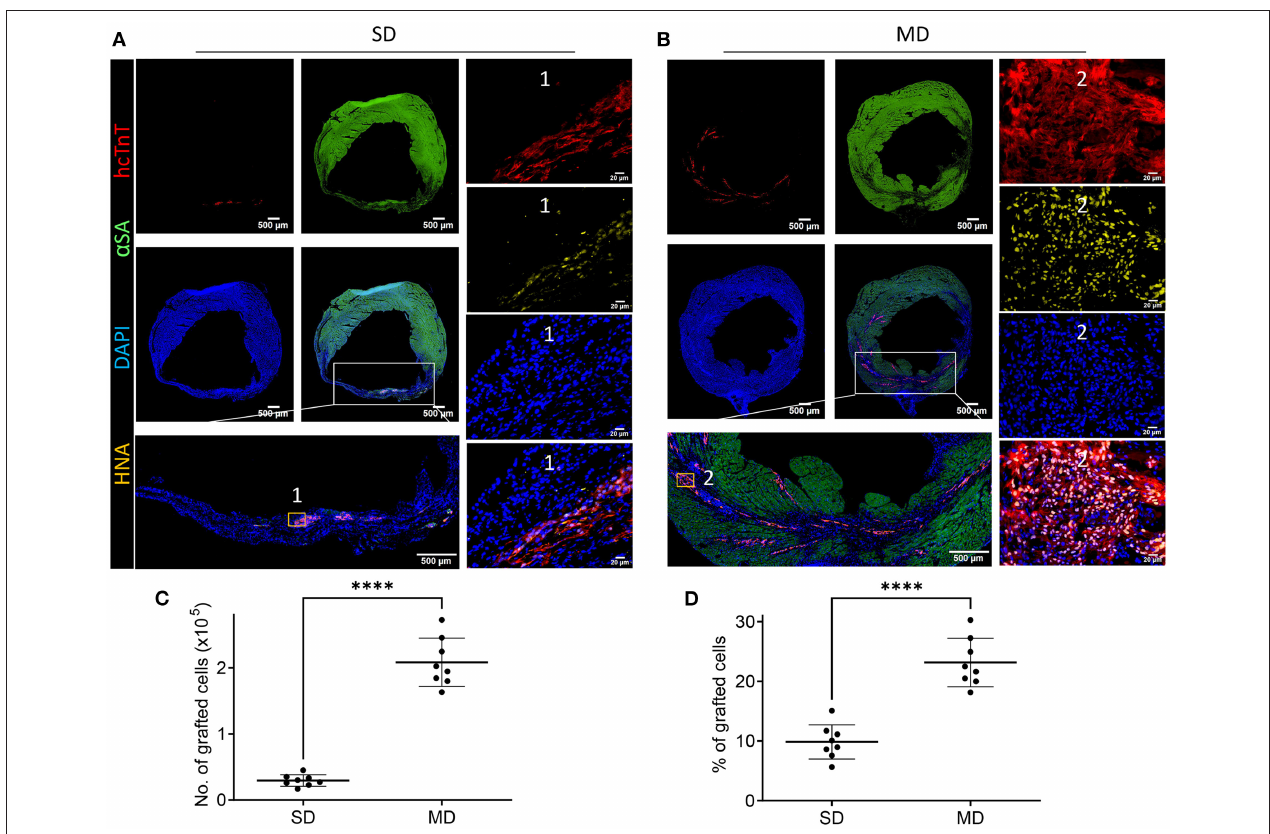
FIGURE 3 | Detection of hiPSC-CMs. Four weeks after MI induction, serial sections of the hearts of mice injected with hiPSC-CM were stained for human cardiac troponin T (hcTnT) and human nuclear antigen (HNA), α -sarcomeric actin ( α SA) and DAPI (A,B) . Transplanted cells were defined as those that expressed hcTnT and HNA and were quantified as the number (C) and percentage (D) of grafted cells. Each heart evaluates 20 parts, and each part randomly selects 5 visual fields for evaluation. Scale bar = 500 or 50m as shown in the panels. Independent-samples t test. **** p <